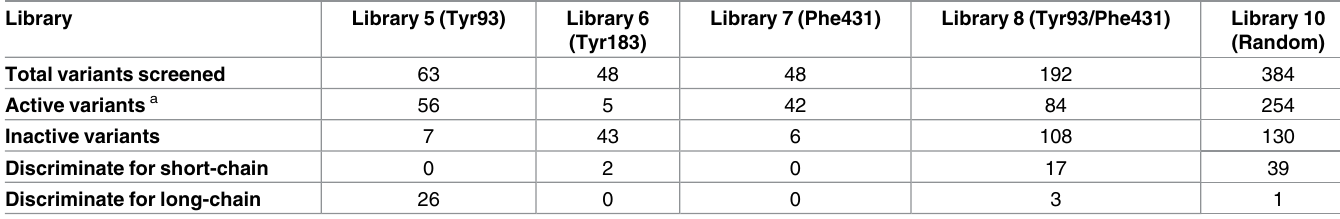
Table 3. Qualitative results of the screening of Cal-A libraries. Library